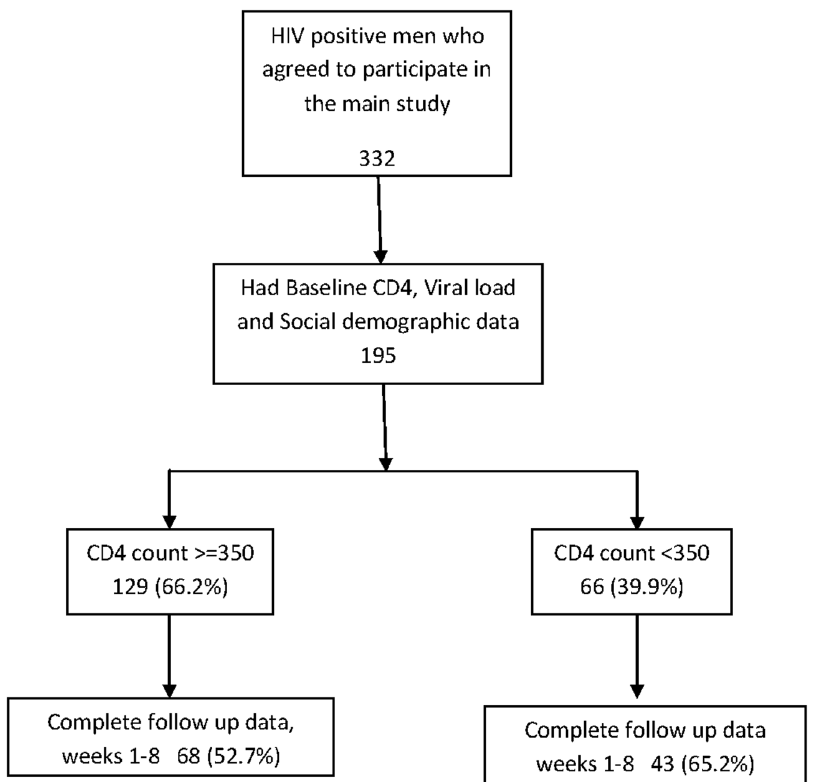
Figure 1. Study Flow